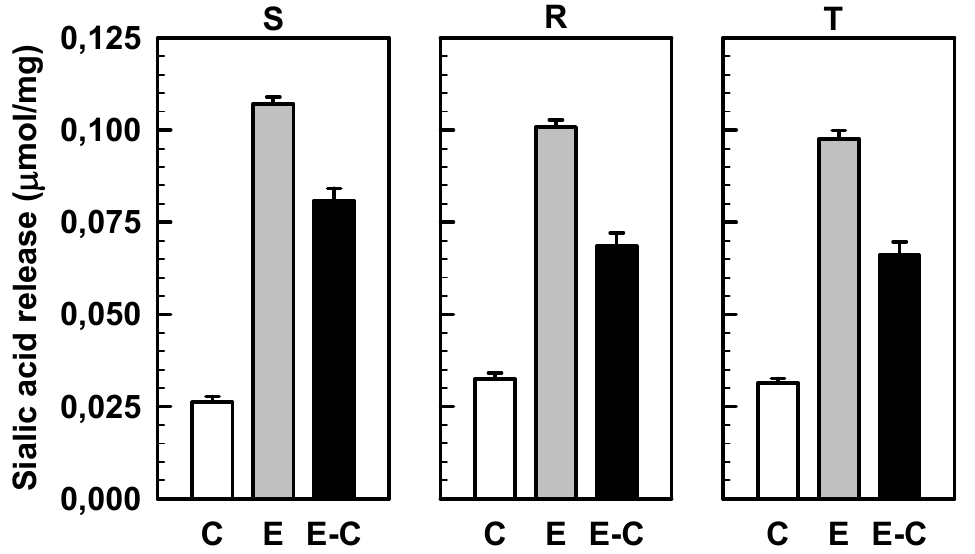
Figure 5. Sialidase induced liberation of sialic acid from S, R and T cells to the external medium. Sialic acid contents were quantified in the external medium after the incubation of cells with sialidase in phosphate buffered saline (PBS) for 10 h (E). As a control, external medium was added after incubation of the cells in the absence of sialidase (C). The net amount of sialic acid liberated by the sialidase reaction represents the difference (E-C). Data represent the mean ± SD of three independent